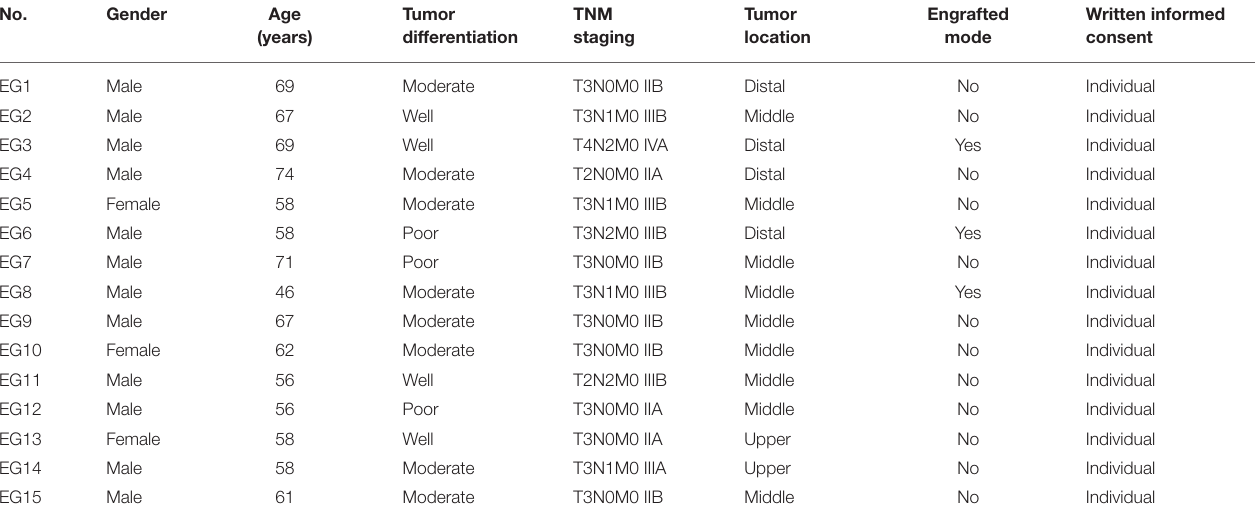
TABLE 1 | Clinical characteristics of studied patients.